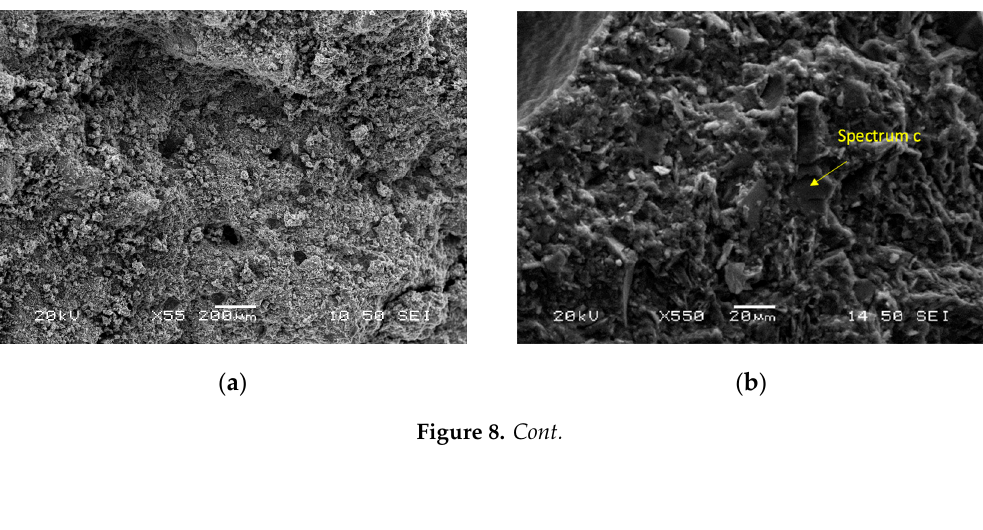
Figure 7. FTIR spectra of brick precursor and selected brick geopolymers.